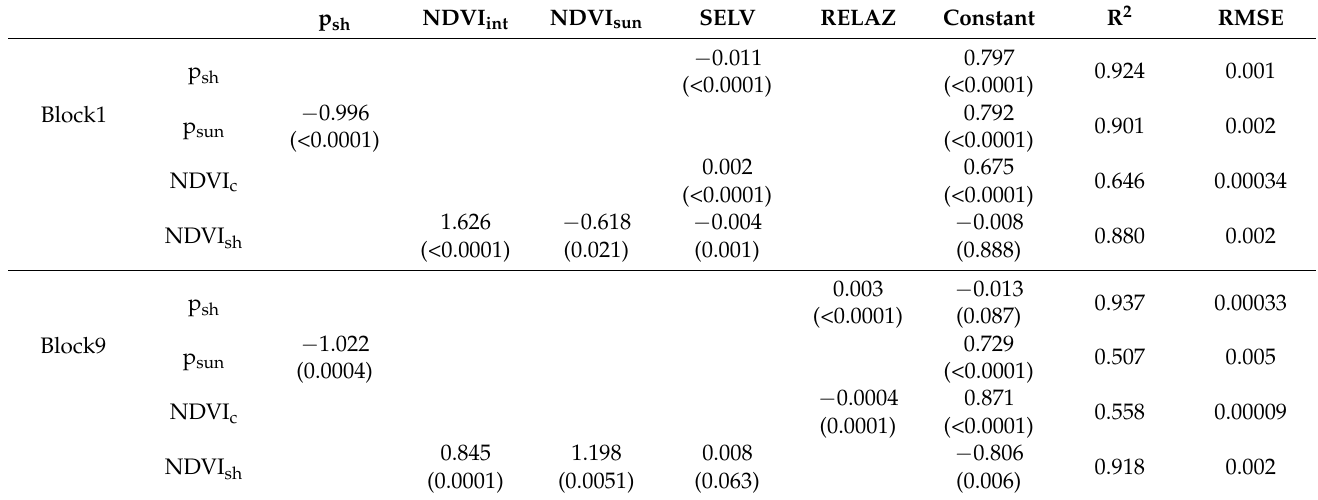
Table 5. Regression parameter coefficients and their respective p -values, coefficient of determination (R 2 ), and Root Mean Square Error (RMSE) for p sh , p sun , NDVI c , and NDVI sh as functions of variables exhibiting lowest p -values and highest coefficients of